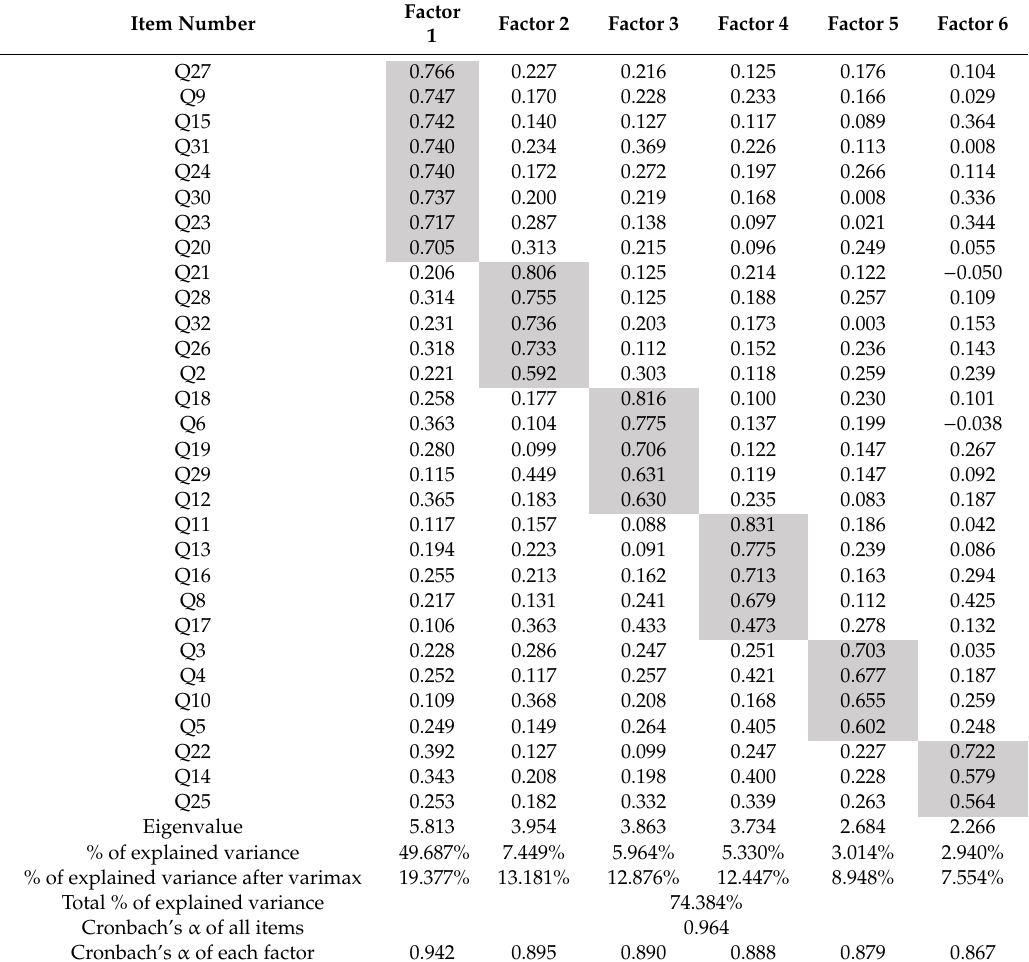
Table 8. Summary of principal component analysis using varimax